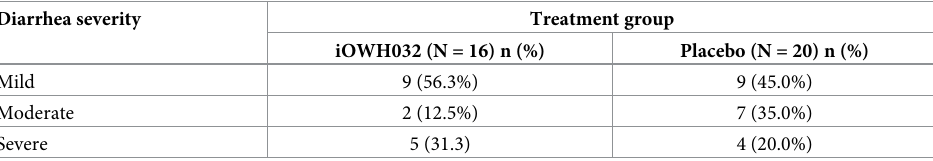
Table 5. Diarrheal disease severity by treatment group for the modified intent-to-treat population.